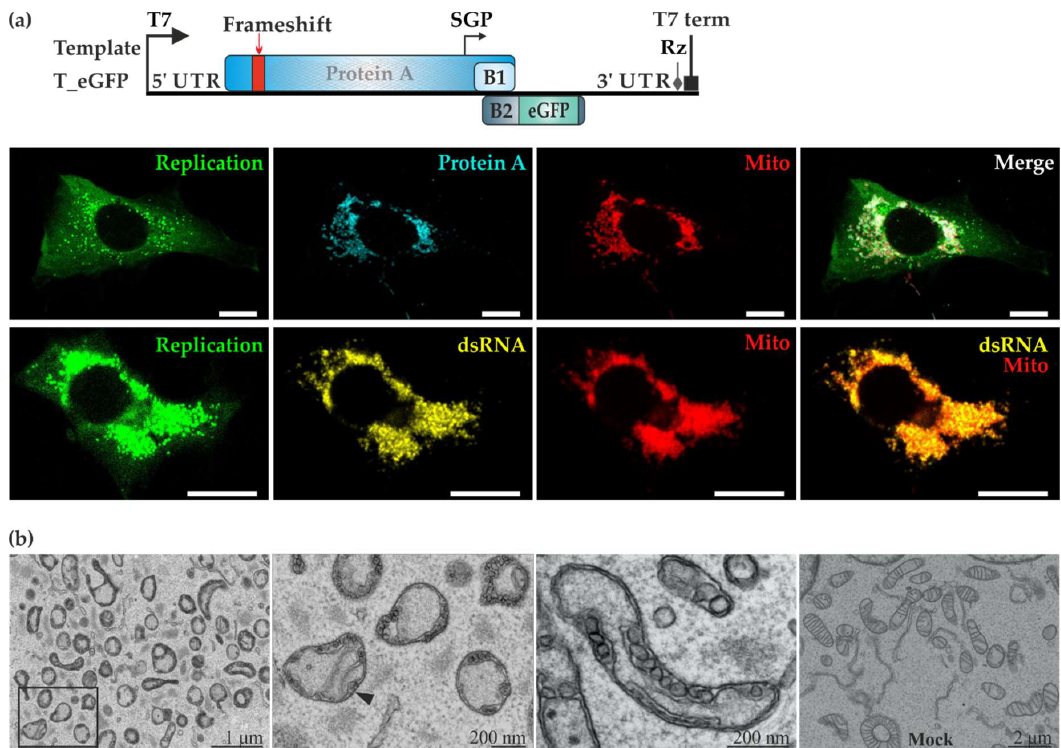
Figure 2. FHV uses the mitochondria of BSR T7/5 cells as replication niche. ( a ) The template T_eGFP expresses enhanced green fluorescent protein (eGFP) under the subgenomic promoter. BSR T7/5 cells were co-transfected with P_HA and T_eGFP. In the upper row, protein A (shown in cyan) was detected with anti-HA antibodies whereas mitochondria (shown in red) were detected with anti-Tom20 antibodies. In the lower row, double-stranded RNA (dsRNA, shown in yellow) was detected together with Tom20 (shown in red). In both rows, the cytoplasmic green fluorescence due to eGFP is shown on the left and the merged image on the right. The scale bars are 10 µM. ( b ) BSR T7/5 cells showing active replication were identified by green fluorescence and analyzed using correlative light electron microscopy (CLEM). Spherules were observed on the outer mitochondrial membranes in RNA replicating cells, as shown in different magnifications (three panels on the left). The black arrowhead indicates the neck structure of a spherule. No spherules were detected in cells transfected expressing P_GAA_Vis (which produces a red fluorescent marker from a second open reading frame) and T_eGFP (rightmost